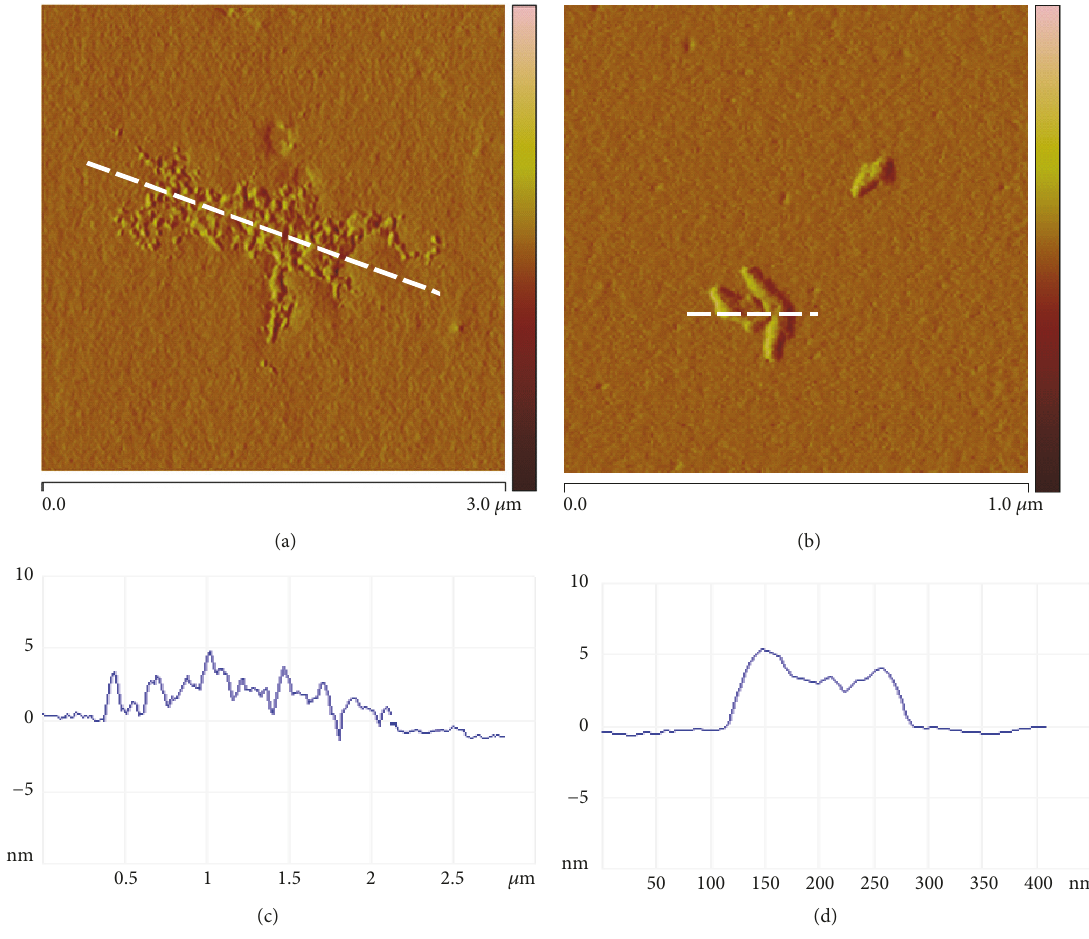
Figure 2: Represent 1 tive t 1 pping mode 0 FM deflection im 1 ge of ( 1 ) non-sonicated GO NPs 1 nd (b) sonic 1 ted GO NPs. (c 1 nd d) The corresponding height profiles along the d 1 shed lines in 11 nd b, showing the height